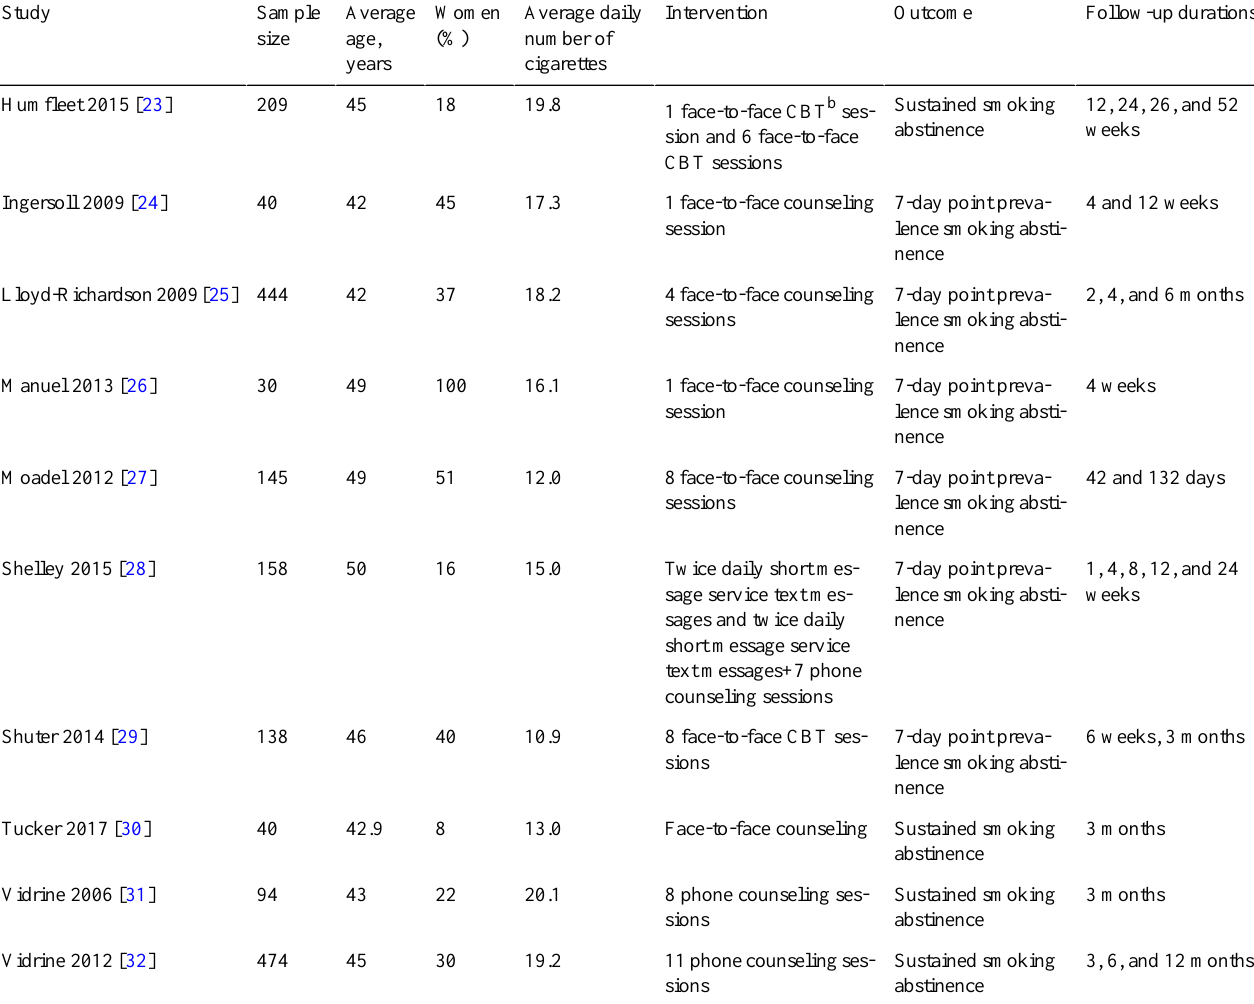
Table 1. Characteristics of the included